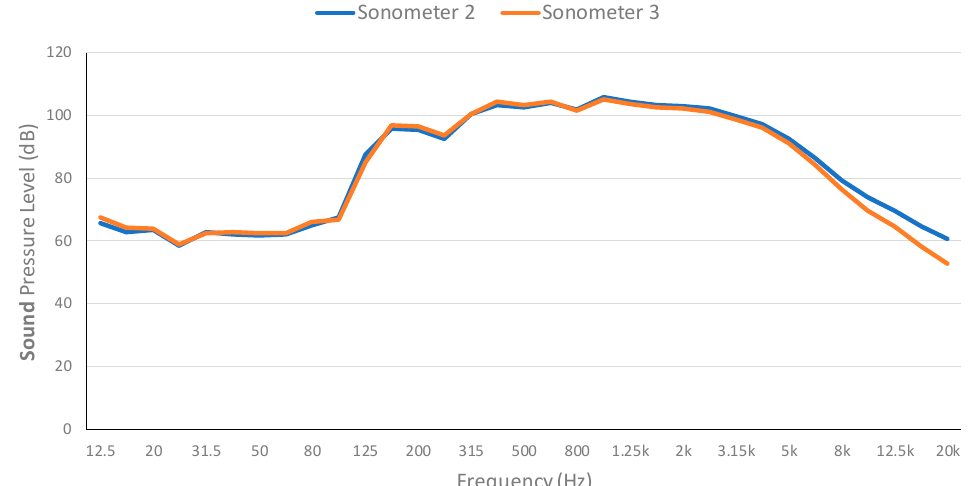
Figure 7. Evolution of the continuous sound pressure level for each frequency band (Sonometers 1 and 2).